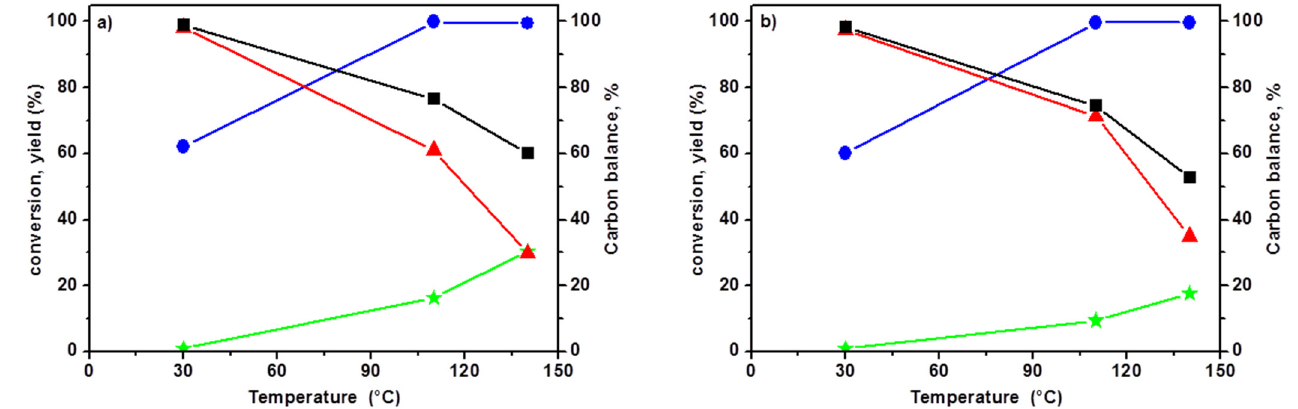
Figure 6. Effect of reaction temperature on conversion and yield to products in the presence of ( a ) Au/AC_PVA and ( b ) Au/AC_PVP catalysts: ( ● ) HDO conversion, (*) AA yield, ( ▲ ) HHA Yield, ( ■ ) Carbon balance. Reaction conditions: HDO 42 mmol L − 1 , 20 mL H 2 O, nHDO/nAu =250, 800 rpm, 15 bar air, 4 h, stabilizer/Au weight ratio of 1.2.